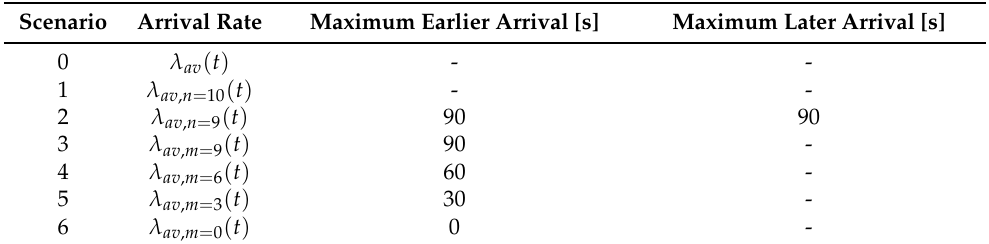
Table 3. Scenarios to be discussed. Scenario 0 is the original arrival flow, and - represents no